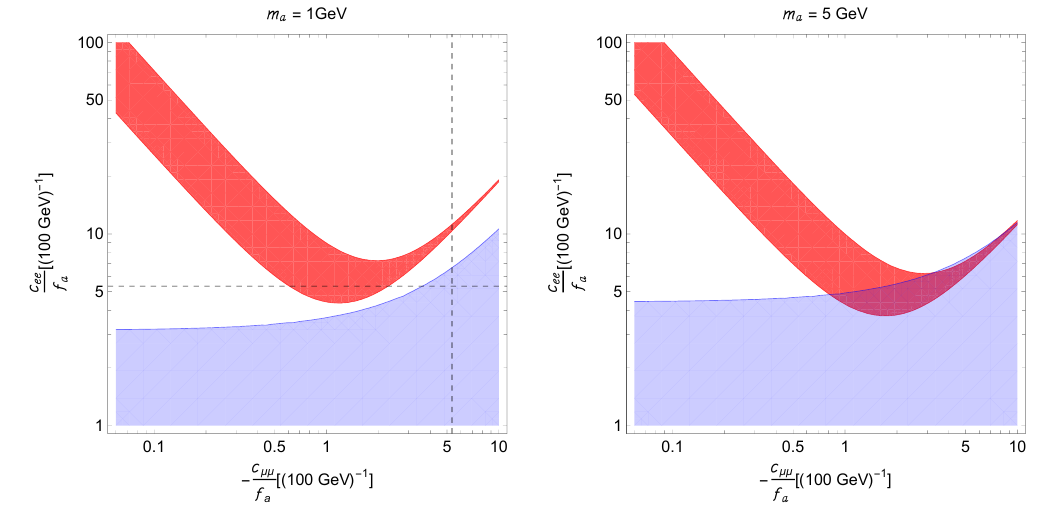
Figure 4 . Regions compatible with muon g − 2 data (red) and electron g − 2 (blue) at 2 σ level, in the ( c , c ) plane. Left: m = 1 GeV; right: m = 5 GeV. In the left plot, the black dashed µµ ee a a